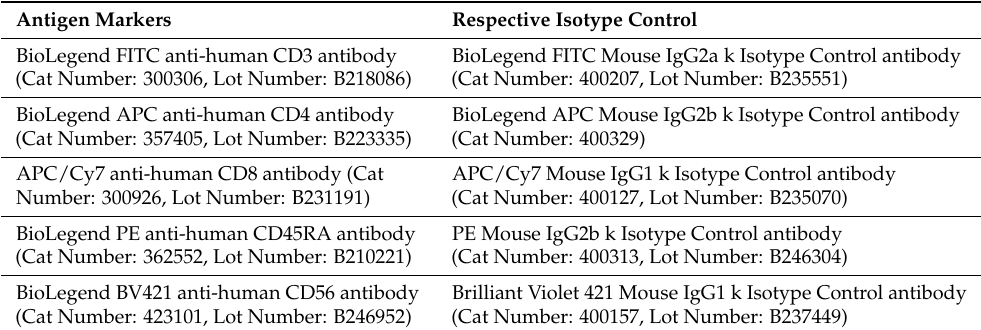
Table 1. Antigen markers and respective isotype controls. Antigen Markers Respective Isotype